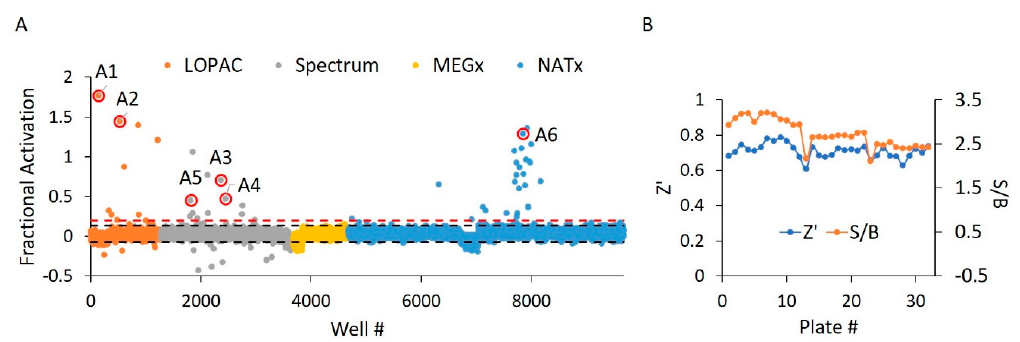
Figure 5. WT HYPE activator high-throughput screen. ( A ) Δ 102 WT HYPE FP autoAMPylation reaction incubated with compounds from either LOPAC, Spectrum, MEGx, or NATx libraries. All samples were normalized to Δ 102 WT and E234G HYPE controls on the same plate in DMSO-containing buffer. Each dot represents a different compound incubated with a single AMPylation reaction in a separate well. Black dashes represent +/ − 3 SD from the mean. Red dashes are the 20% hit definition, with all dots above this threshold being hit compounds. Dots with red circles show hits selected for follow-up, orthogonal validation. ( B ) Plate-to-plate variability in the positive (E234G HYPE) and negative (WT HYPE) DMSO controls from WT HYPE high-throughput screening (HTS). Left and right y-axes are for Z’ and S/B values, respectively. Each dot represents the calculated Z’ or S/B values from 24 E234G HYPE positive controls and 24 WT HYPE negative controls within a single plate.